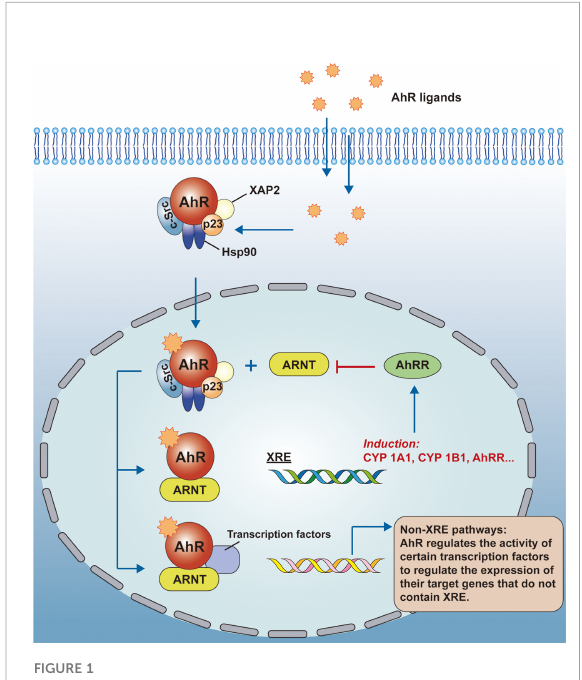
FIGURE 1 AhR signaling pathway. AhR is a ligand-activated transcription factor and inactive AhR forms a complex with Hsp90, XAP2, c- Src, and p23 in the cytoplasm. As AhR binds to the ligand, conformational changes occur, and they form complexes with the ARNT to enter the nucleus. the genomic regulatory region of AhR target genes contains the XRE, and in the nucleus, besides recognizing the XRE, the AhR-ARNT complex also interacts with other transcriptional regulators to control the expression of multiple target genes. AhR, aryl hydrocarbon receptor; ARNT, aryl hydrocarbon receptor nuclear transport protein; XRE, exogenous response element; CYP, cytochrome